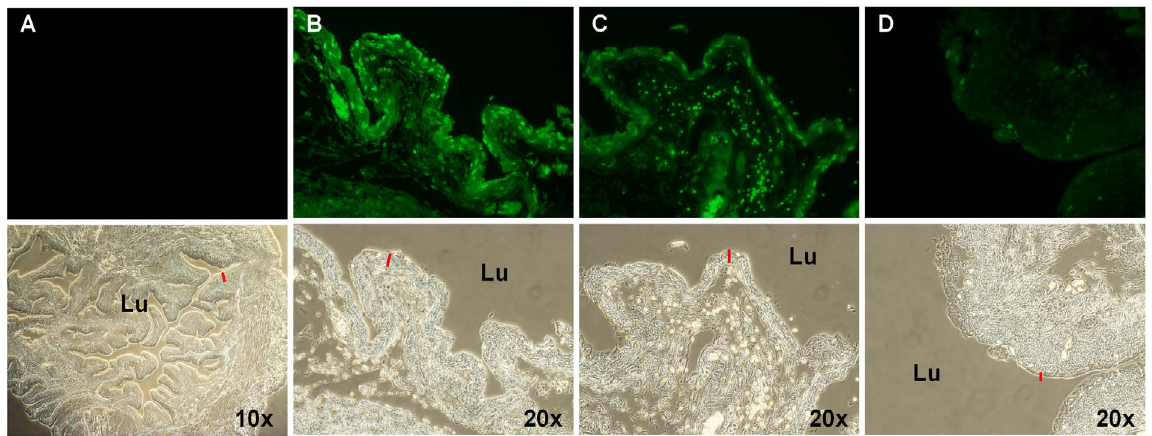
Figure 2. LL-37 induces apoptotic cell death in the urinary bladder. The mucosal cells in the urinary bladder undergo apoptotic cell death and are removed quickly. TUNEL stain (top panels) and corresponding bright field (bottom panels) images of bladders from (A) normal animal, (B) normal bladder treated with TACS nuclease for positive control, (C) 1 hr after LL-37 (320 m M) challenge, and (D) 3 hr after LL-37 challenge. Red lines indicate the urothelial layers. Lu is the lumen of the